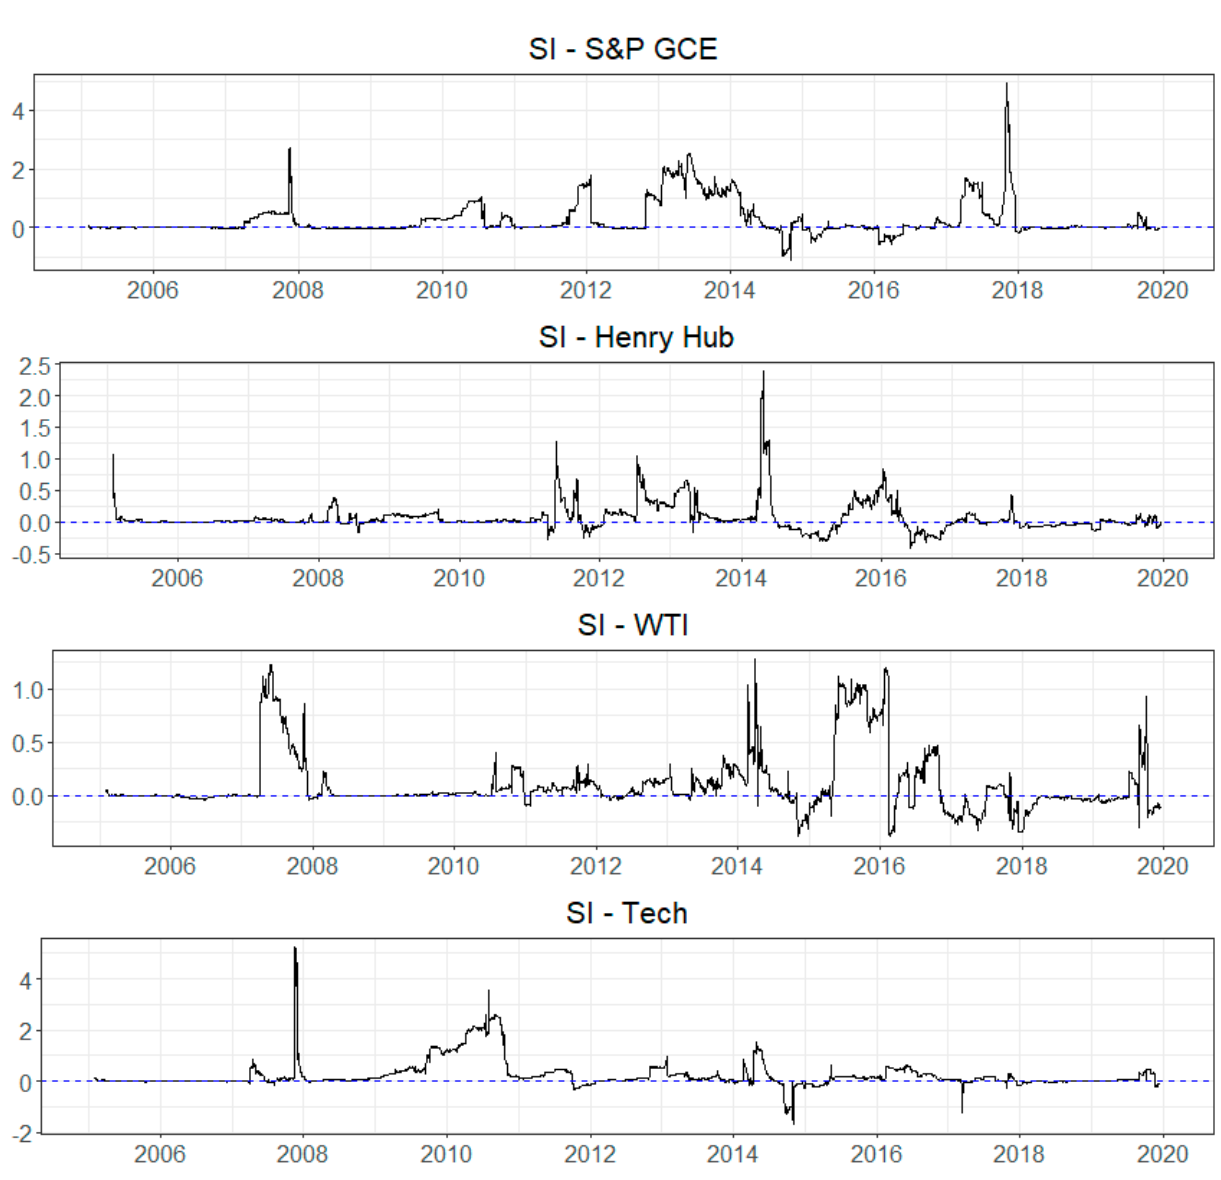
Figure A5. Dynamic net pairwise directional volatility connectedness (SI).